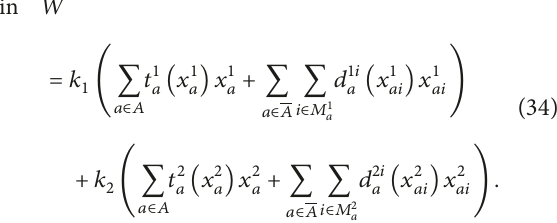
and 6-3. The solid lines in the figure represent the lanes for RVs. The dash lines indicate the lanes for AVs. Relevant parameters of the road network are shown in Table 1.